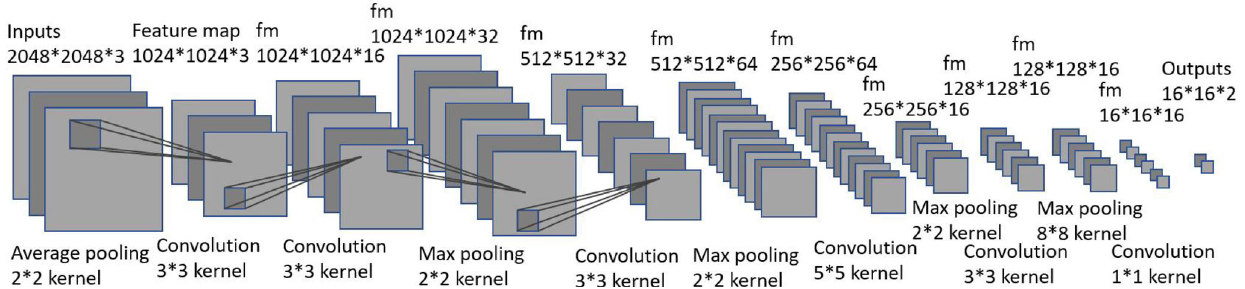
Fig. 2 CNN layers of BlockNet. This network is designed so that every computation does not produce any offset to centers of 16 × 16 blocks, and all blocks are distributed evenly. The output of BlockNet has two channels: one represents background, and the other represents foreground. Due to its simplicity, this network takes less than 1 ms to process an image. To boost the performance of the whole framework, some modifications must be included in this stage, replacing the 8 × 8 pooling layer with another two convolution layers.